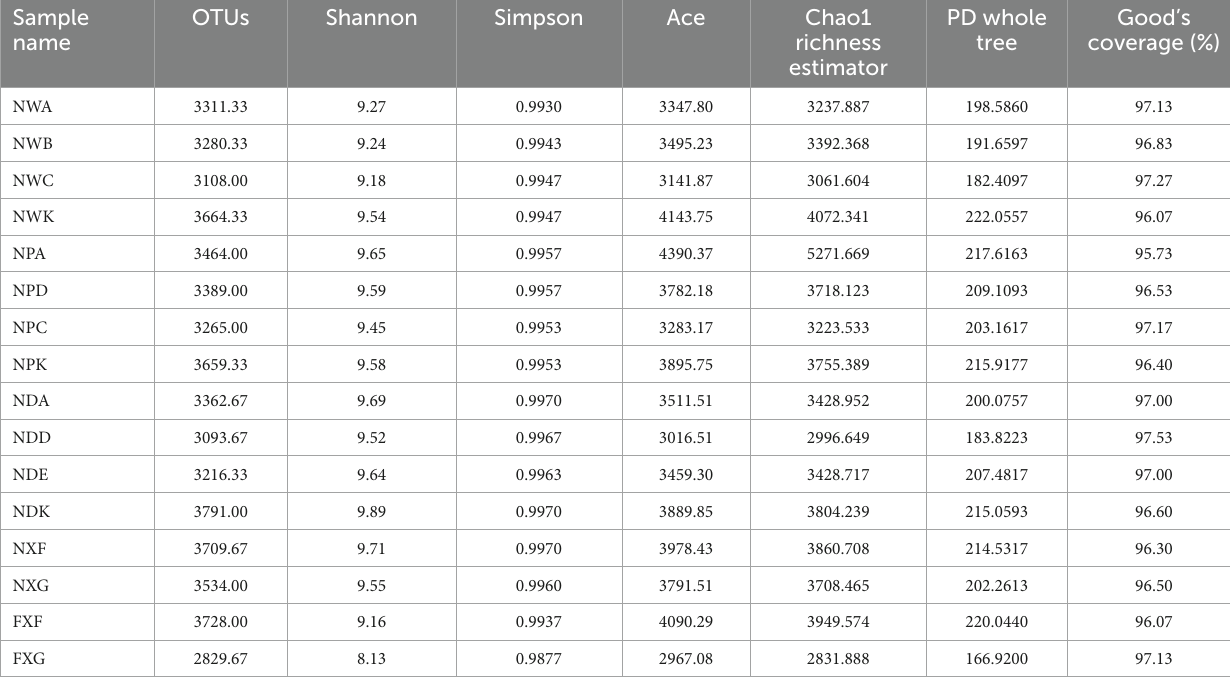
TABLE 3 Mean bacteria diversity index of the